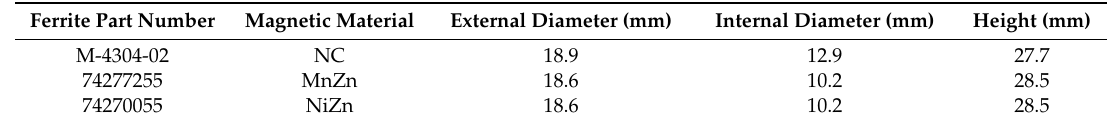
Table 1. Lists of cable ferrites used in this